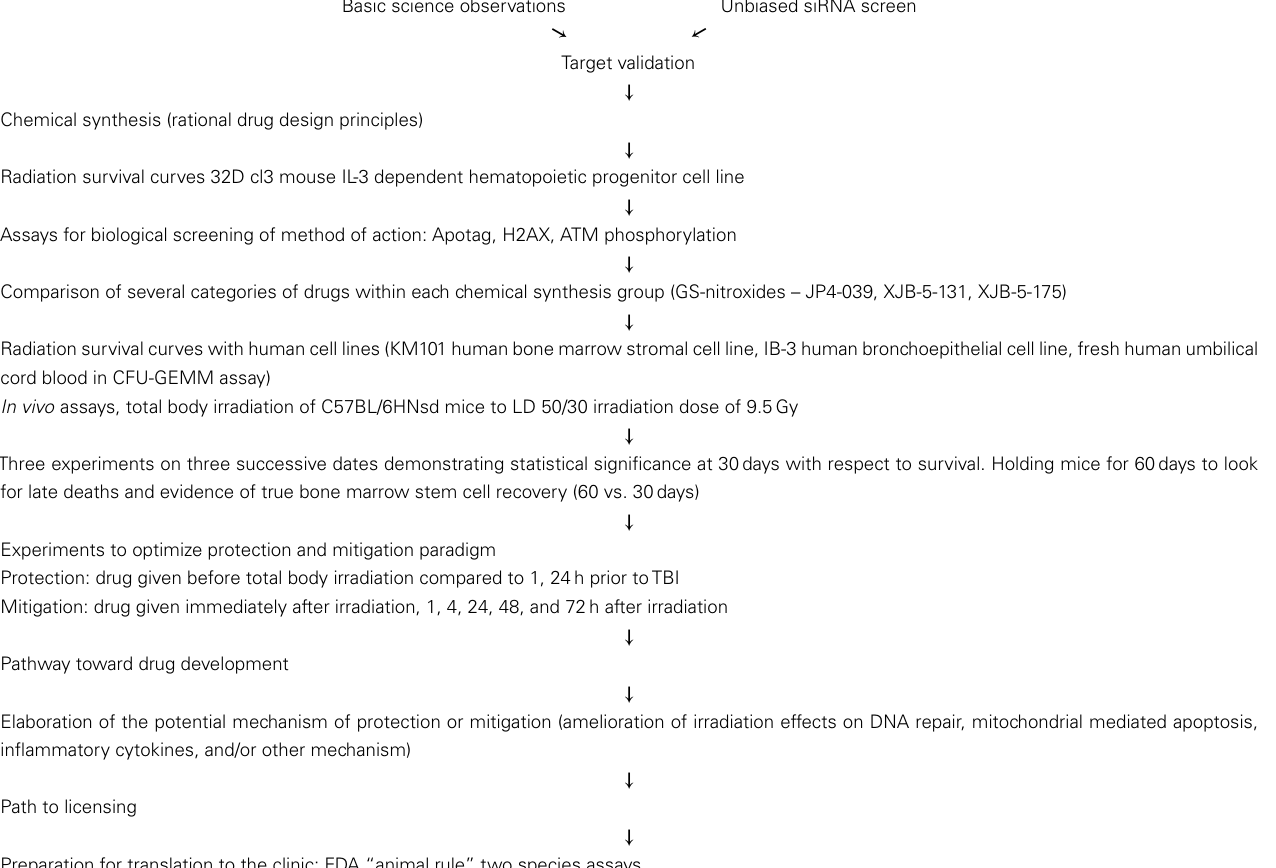
Table 1 | Drug discovery pathways for small molecule radiation protector/mitigator